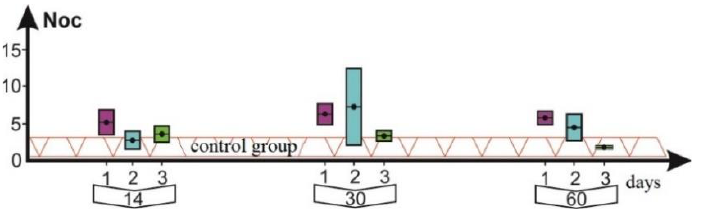
Figure 9. Dynamics of the number of osteoclasts (N.Oc).